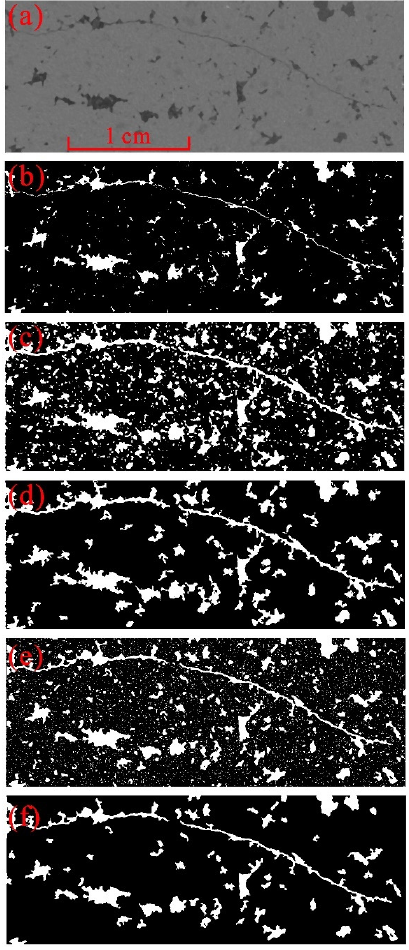
Figure 3. Different methods applied to fracture acquirement: ( a ) the filtered image, ( b ) the segmented pore space by watershed method, ( c ) the segmented pore space after histogram equalization enhancement, ( d ) the filtered image of the subgraph ( c ), ( e ) the segmented pore space after top-bottom hat algorithm, ( f ) the filtered image of the subgraph ( e ).